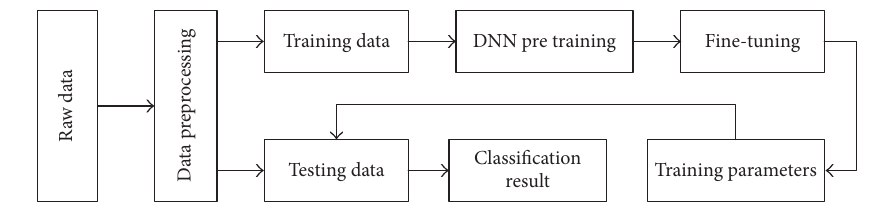
Figure 3: Framework of fault classification based on DNN.